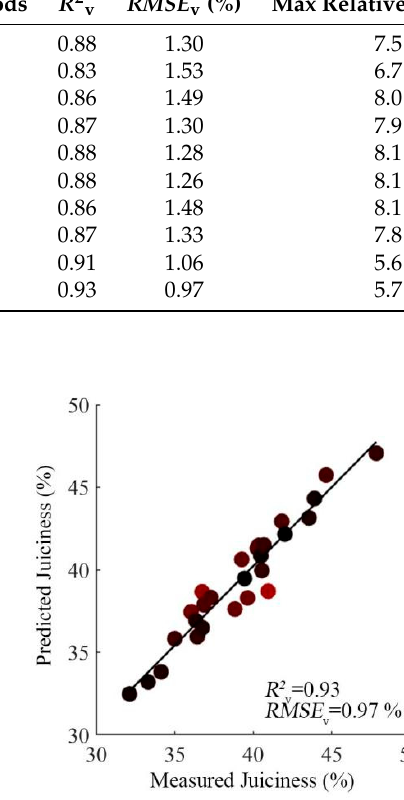
Figure 8. Scatter plots of the simplified models for the prediction after LRC-SR preprocessing methods.